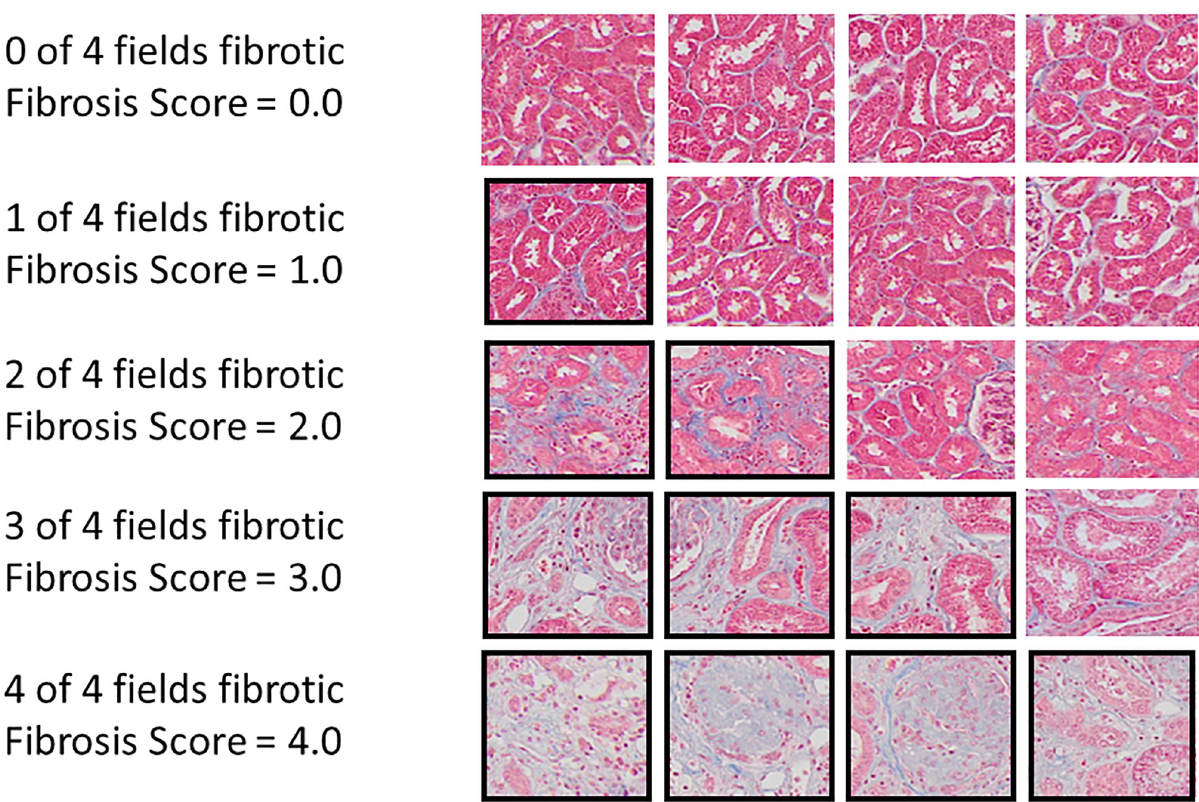
Fig 4. Histologic fibrosis scoring. Microscope fields at 100 x magnification of Masson’s Trichrome stained kidney sections representing fibrosis scores of 1 to 4. Collagen is stained blue.